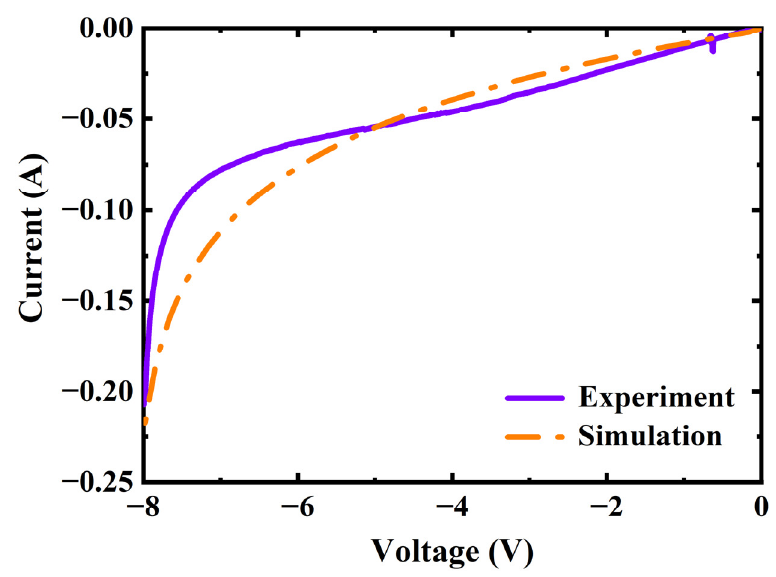
Figure 10. Polarization curves obtained through experiment and simulation .